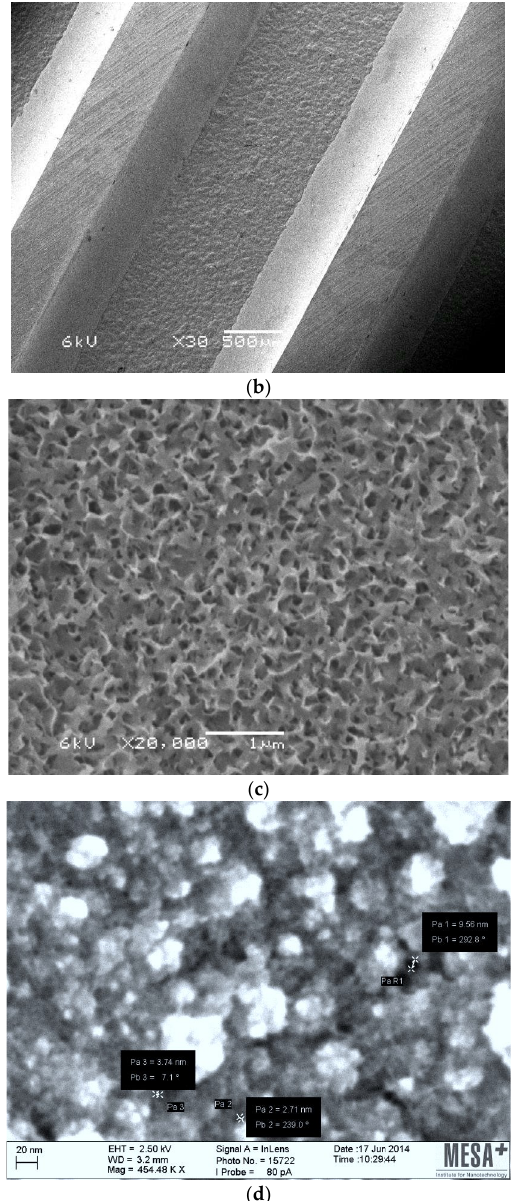
Figure 7. SEM images of membranes developed by Metalmembranes: ( a ) The outer surface of the ceramic layer before electrochemical machining (ECM), ( b ) after ECM flow channels in aluminium membrane, showing the metal support bars and the inner surface of the ceramic layer, ( c ) magnification of the pores (100–150 nm) on the inner ceramic layer of an aluminium membrane, ( d ) magnification of the pores (2–10 nm) on the inner ceramic layer of a titanium membrane. Reproduced from Novel hybrid ceramic metal membrane [108] with permission from Metalmembranes.